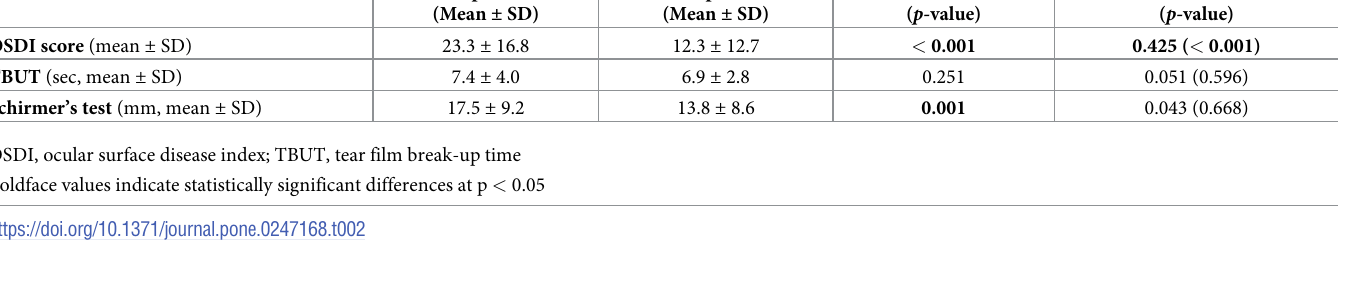
Table 2. Changes in OSDI scores, TBUT and Schirmer’s test before and after endoscopic dacryocystorhinostomy of 110 patients. Parameters